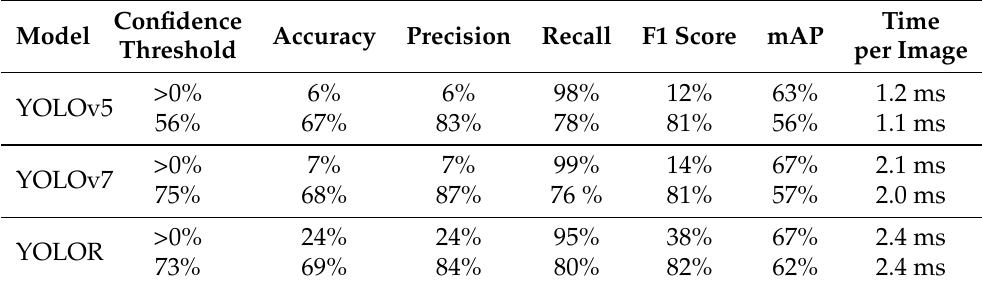
Table 13. Detection results of the testing set obtained with the TensorFlow Flower Detection Dataset.